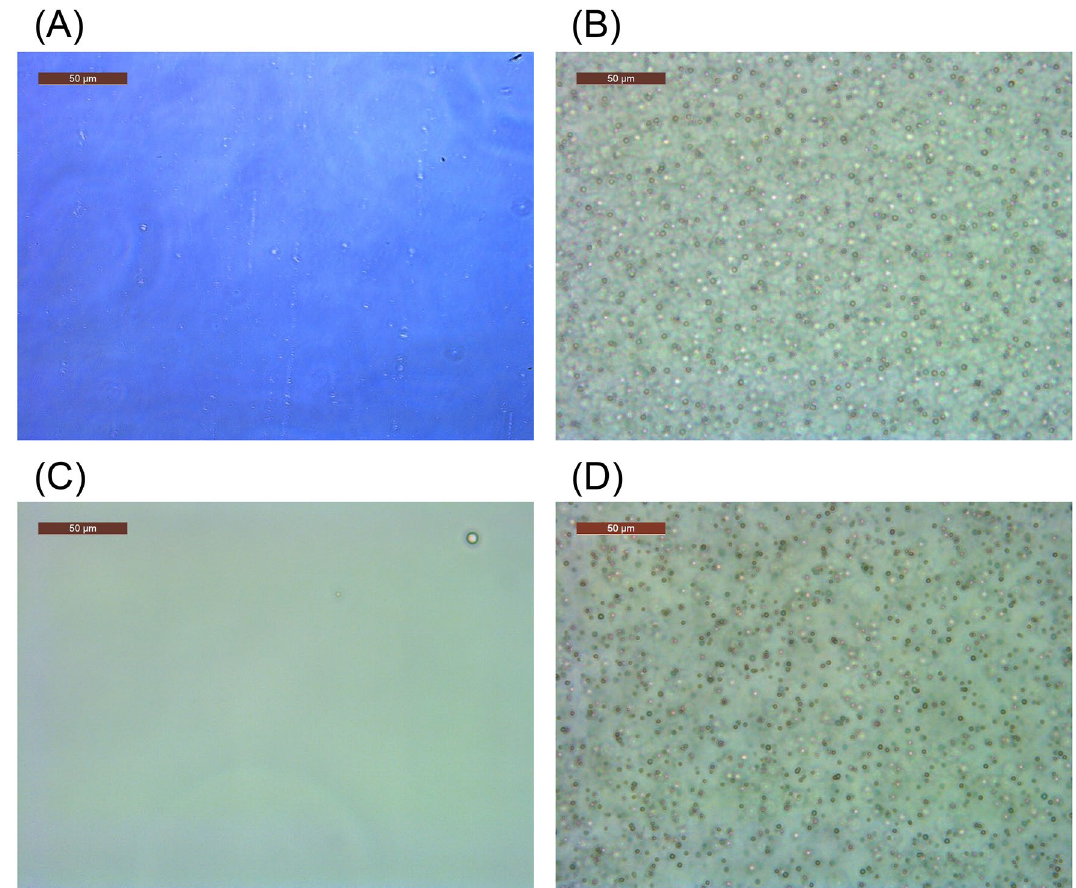
Figure 7. Optical microscopy images of AADAAC-F4 in solution. Images of AADAAC-F4 solution (4.26 mM) dissolved in Tris–HCl buffer (50.0 mM Tris, 599 mM NaCl, pH 8.0) obtained at ( A ) 10 °C, ( B ) 40 °C, and ( C ) 20 °C (after cooling from 40 °C). ( D ) AADAAC-F4 solution (4.26 mM) dissolved in Tris–HCl buffer in the presence of equimolar amounts of Cd 2+ at 4 °C. Scale bar = 50